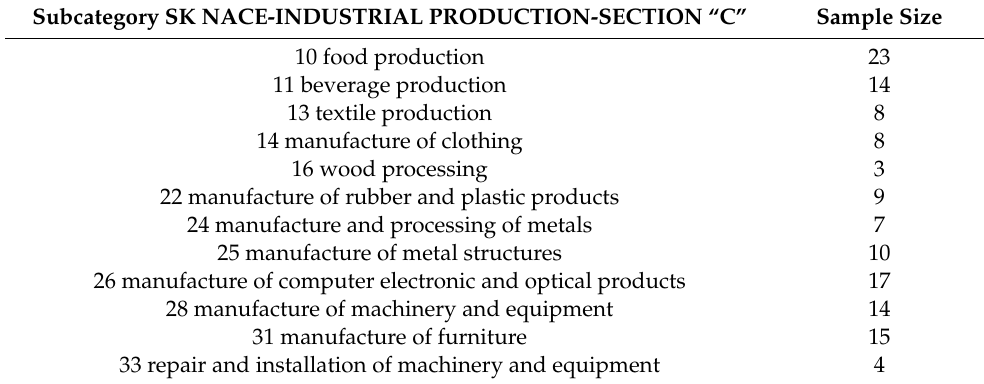
Table 2. Classification of industrial production subcategories according to Slovak